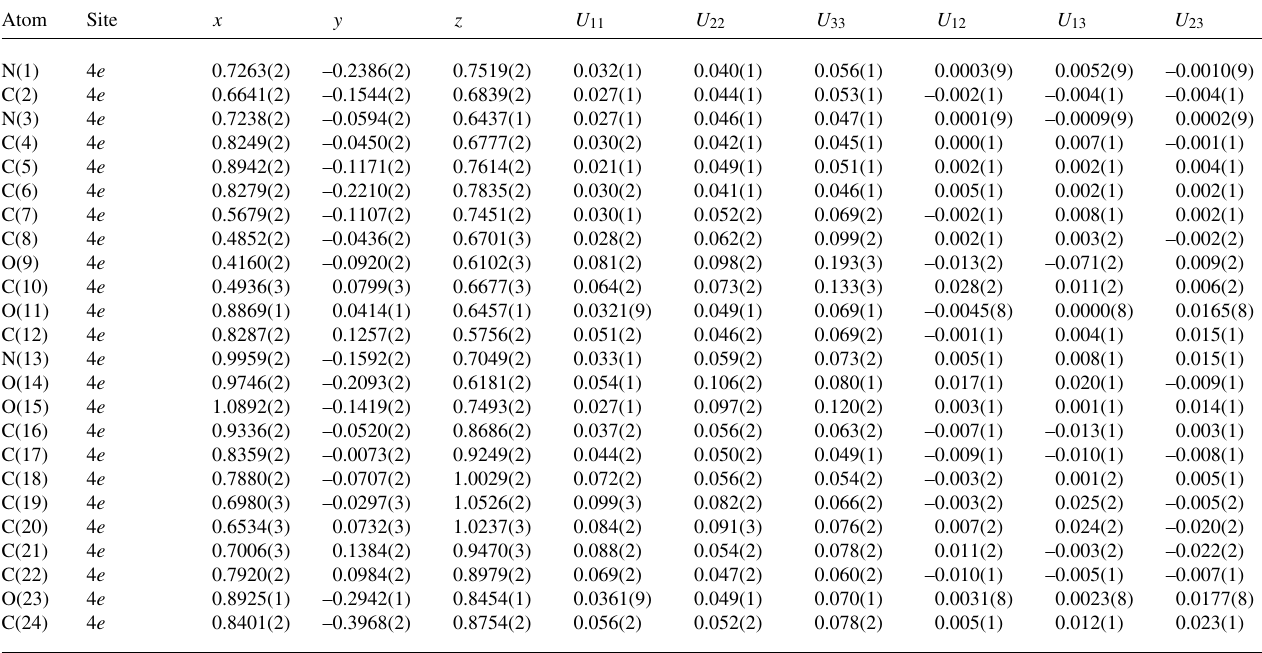
Table 3. Atomic coordinates and displacement parameters (in Å 2 )